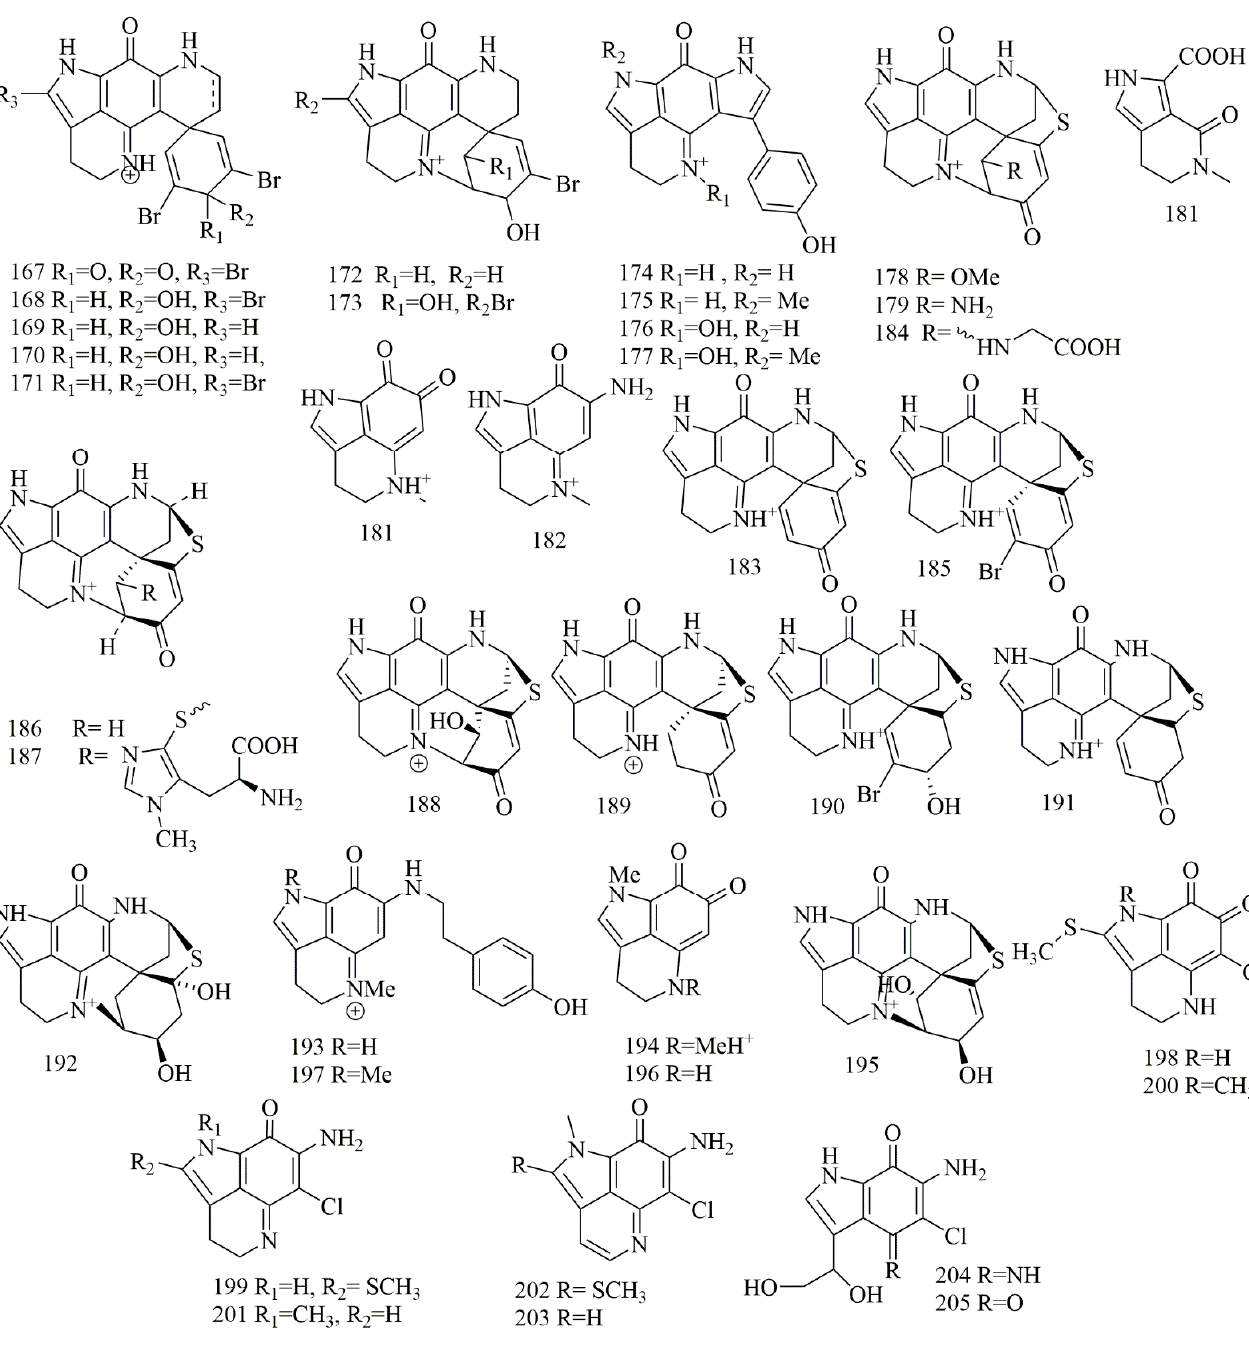
Figure 14. Pyrroloiminoquinone alkaloids structures isolated from sponges. Table 14. Cytotoxic activity of pyrroloiminoquinone alkaloids in sponges.